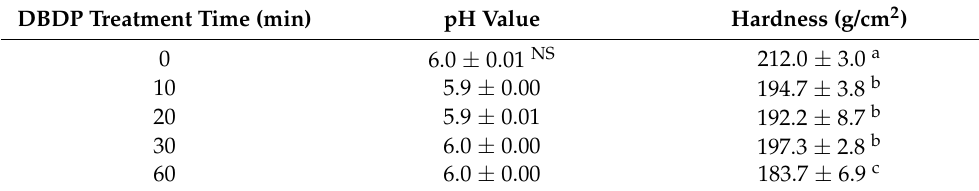
Table 2. pH value and hardness changes in the oyster treated by DBDP. DBDP Treatment Time